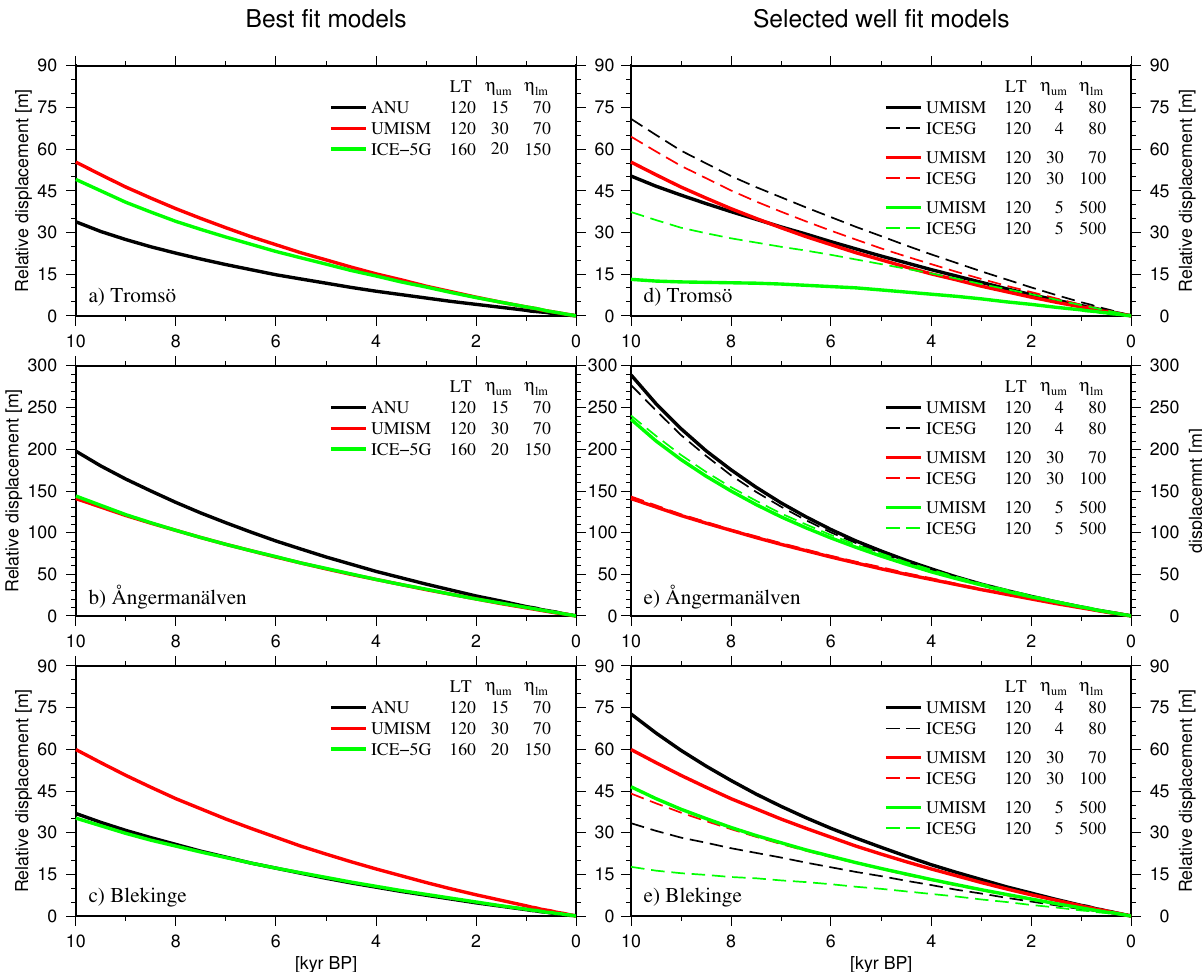
Figure 10. Relative displacements at Tromsö, Norway (top); Ångermanälven, Sweden (middle); and Blekinge, Sweden (bottom), predicted by the best-fit two-layer models (left panel) and selected well-fit models (right panel). The legends show lithospheric thickness, LT, in km and viscosities, η , in units of 10 20